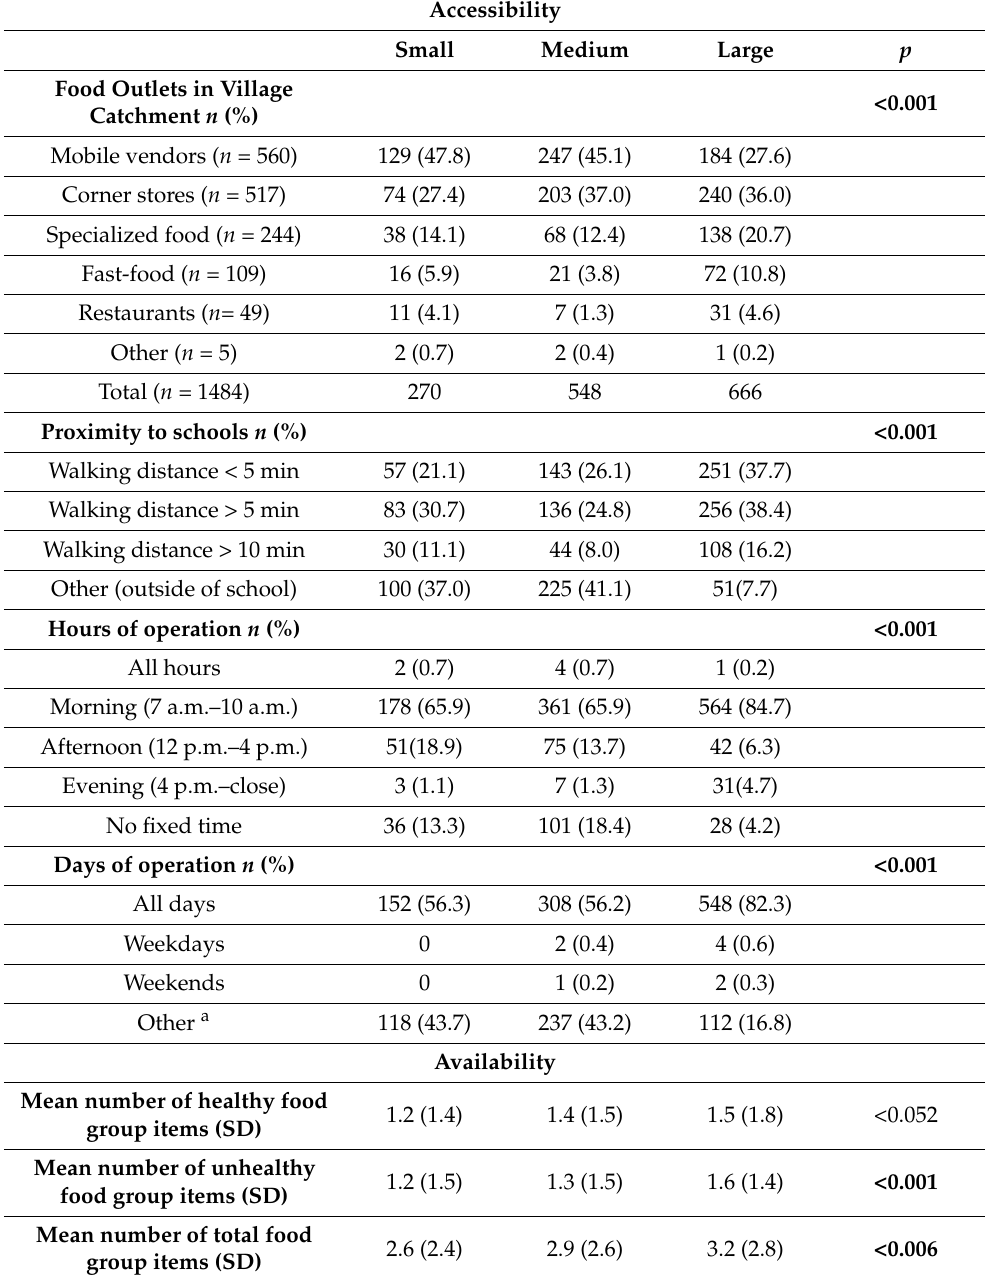
Table 3. Food Outlet Accessibility and Availability by Village Size. Small ( n = 54), Medium ( n = 112), Large ( n = 58). χ 2 test for categorical variables; ANOVA for continuous variables. Accessibility Small Medium Large p